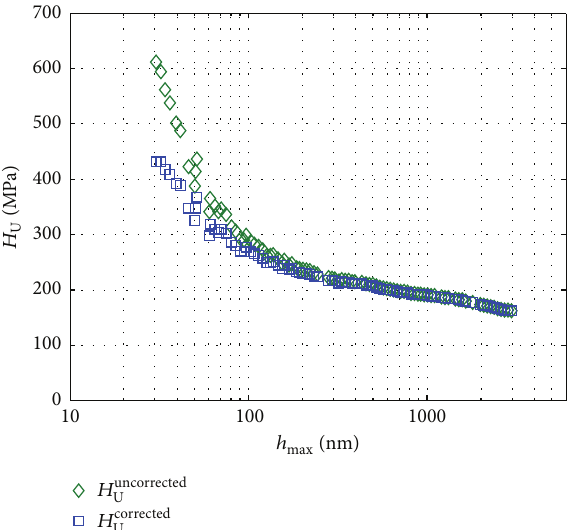
Figure 5: Effect of tip bluntness on the indentation size effect in epoxy with 20phr ( 𝐻 corrected U and 𝐻 uncorrected U represent the universal hardness with and without considering the effect of tip bluntness, resp.) [25].